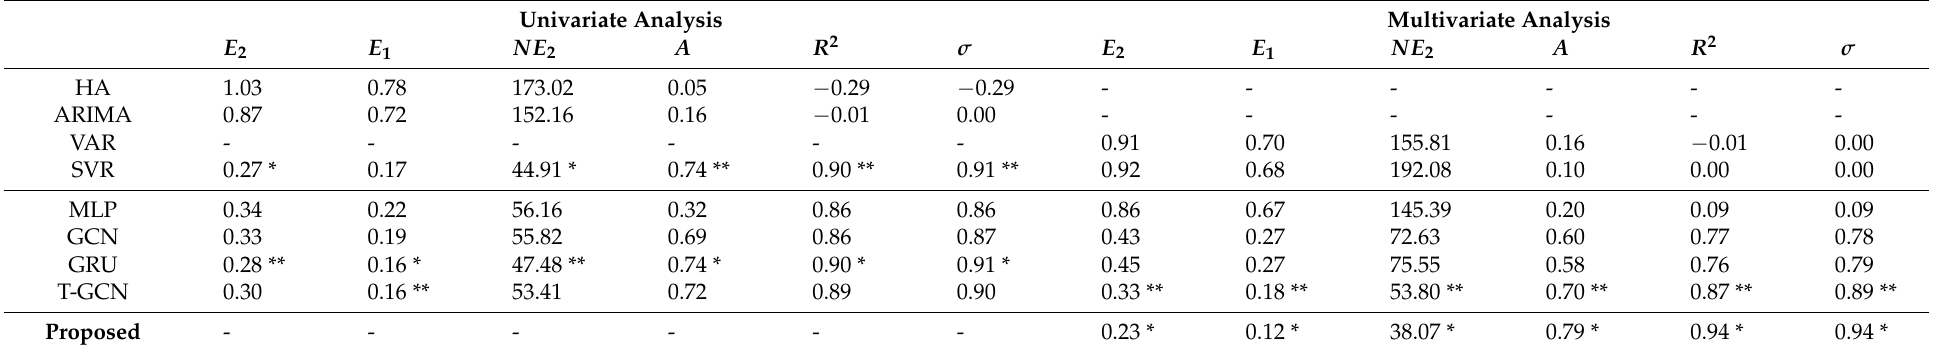
Table 2. A performance comparison of the proposed model with the baseline methods. The upper, middle, and lower parts of this table present the accuracy of the conventional regression models, the deep learning-empowered models, and the proposed model, respectively. Furthermore, the left and right sides exhibit the model accuracy of the univariate and multivariate analysis, respectively. - indicates cases that we cannot assess the models’ accuracy due to their characteristics. Additionally, * and ** denote models with the first and second best performance on each case and metric, respectively. The hyper-parameters were set as L o = 12, L p = 1, N = 4, and θ V =